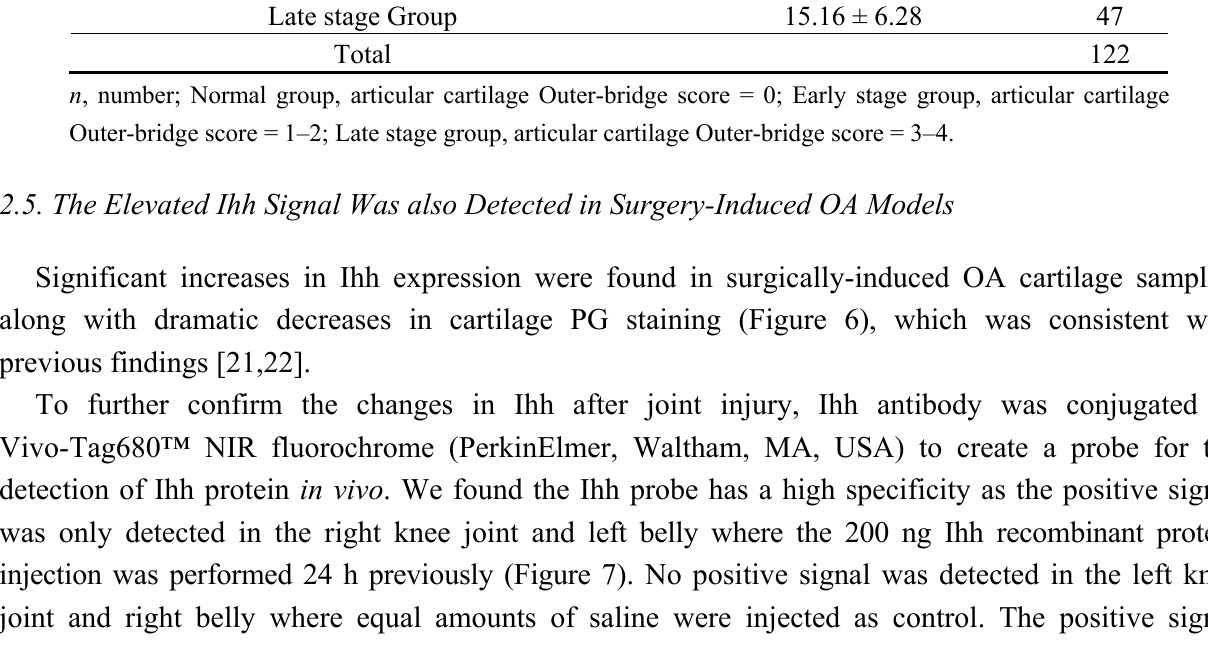
Table 1. Indian hedgehog (Ihh) concentration in SF. Results are presented as the mean ± SD. Group (Based on Outer-Bridge Score) Normal Group